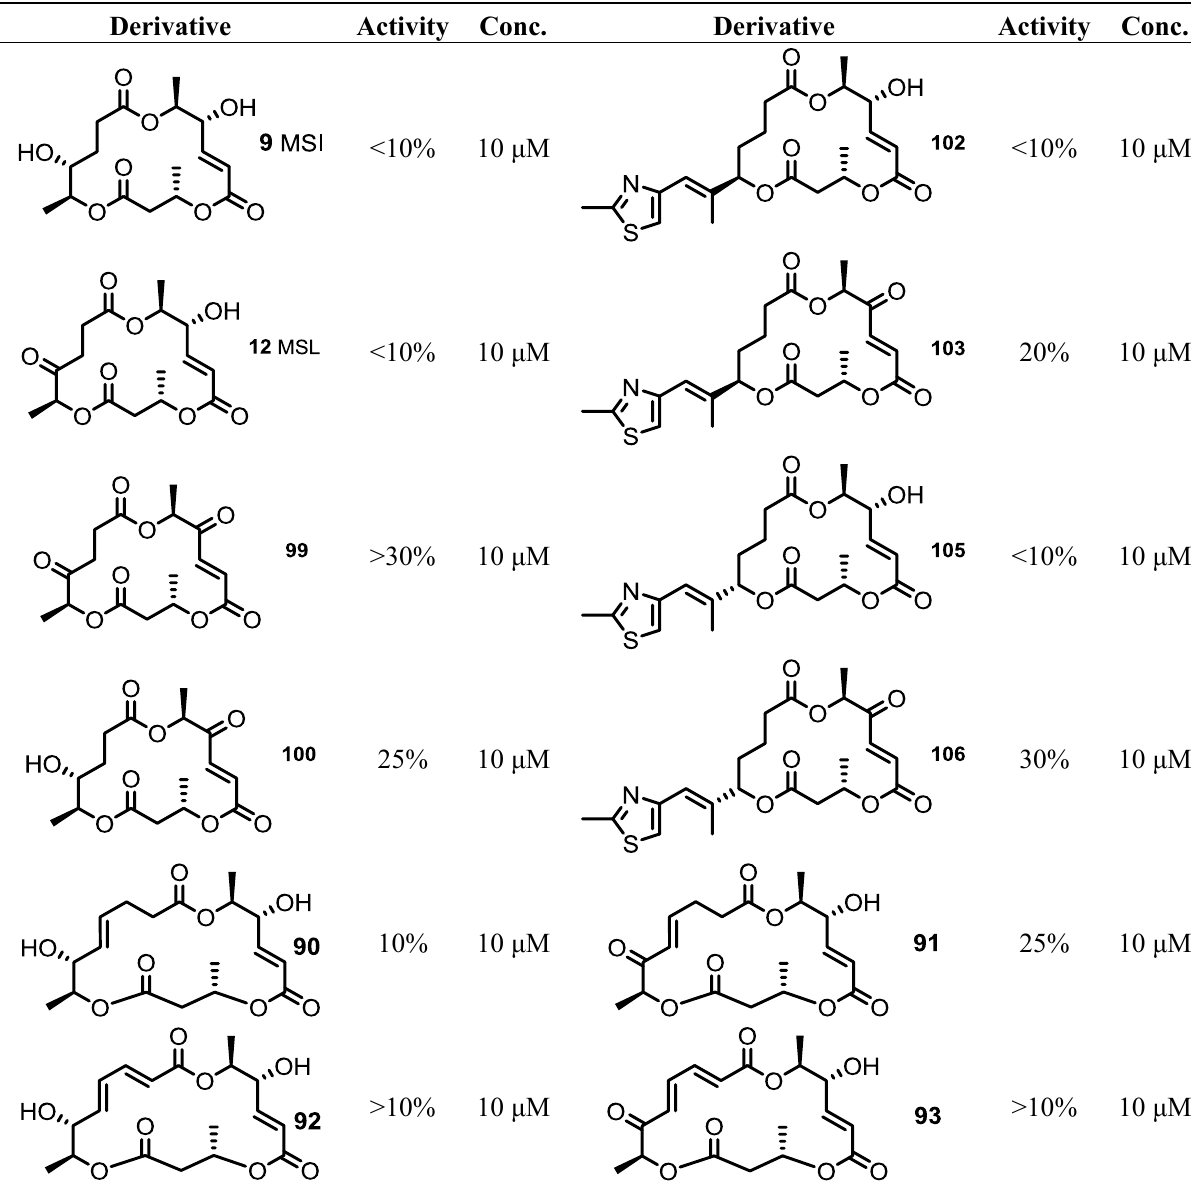
Table 2. Apoptosis Inducing Activity of MS Derivatives Based on DNA Fragmentation a,b